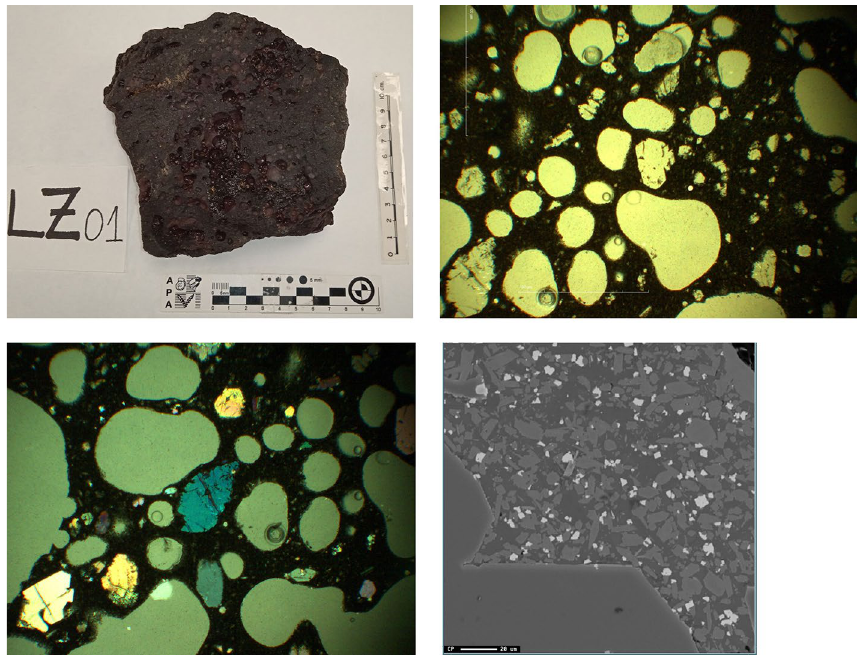
Figure 6. Image of the samples analysed on a macroscopic and microscopic scale with reflected light in parallel and crossed nickels and electron microprobe image. The blue and brown colours correspond to minerals from the olivine group. The black colour corresponds to the vitreous mass that has a mainly pyroxene composition. The data obtained from the electronic microprobe and the SEM–EDX has identified the main mineral